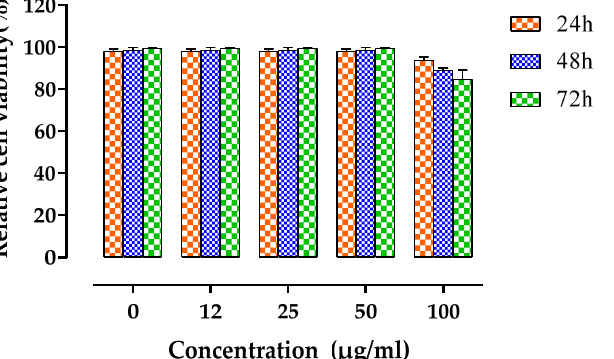
Figure 1. Cytotoxicity of the polyphenol-enriched fraction extracted from Myrtus communis for K562 and HL60 cells. ( A ) K562 and ( B ) HL60 cell viability after 24–72 h of treatment with different con- centrations of the PEMC (12–100 µg/mL). The IC 50 values for K562 ( C ) and HL-60 ( D ) were estimated using nonlinear regression. The absorbance values were measured at the wavelength of 570 nm, and the mean values ± SD of three experiments are displayed along with a representative IC 50 curve. The cell viability was estimated by the MTT assay. * p < 0.05; ** p < 0.01;*** p < 0.001.